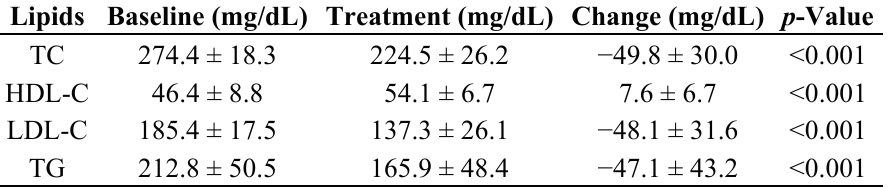
Table 2. Serum lipids levels at baseline and after treatment with atorvastatin (10 mg/day, 4